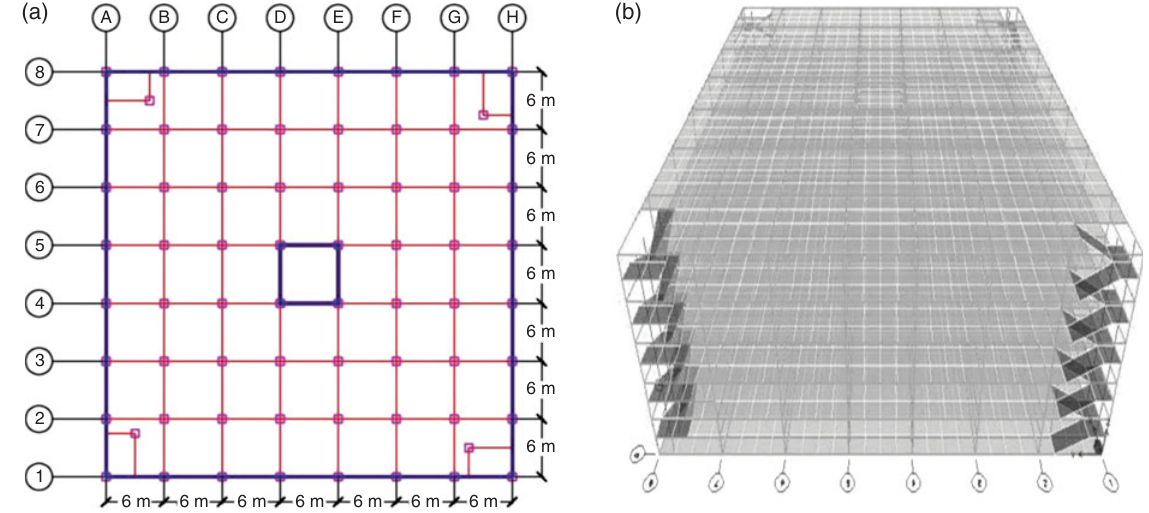
Fig. 2. Model of multi-storey buildings with staircase: (a) plan view and (b) three-dimensional